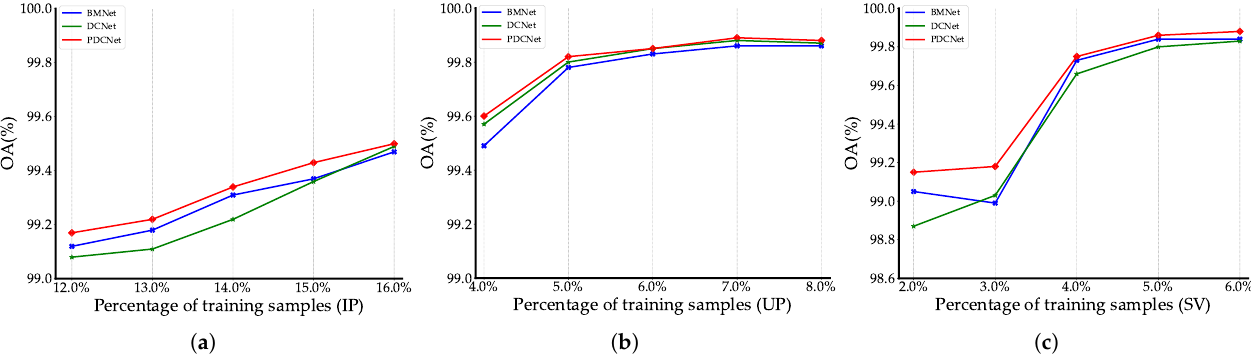
Figure 9. OA of different training samples with three datasets on BMNet, DCNet and PDCNet. ( a ) OA on IP dataset. ( b ) OA on UP dataset. ( c ) OA on SV dataset.